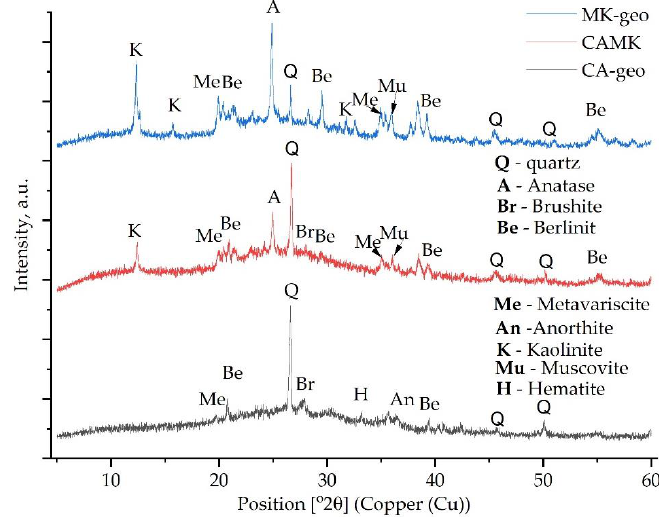
Figure 4. The XRD pattern of the acid-activated geopolymers without mine tailings.